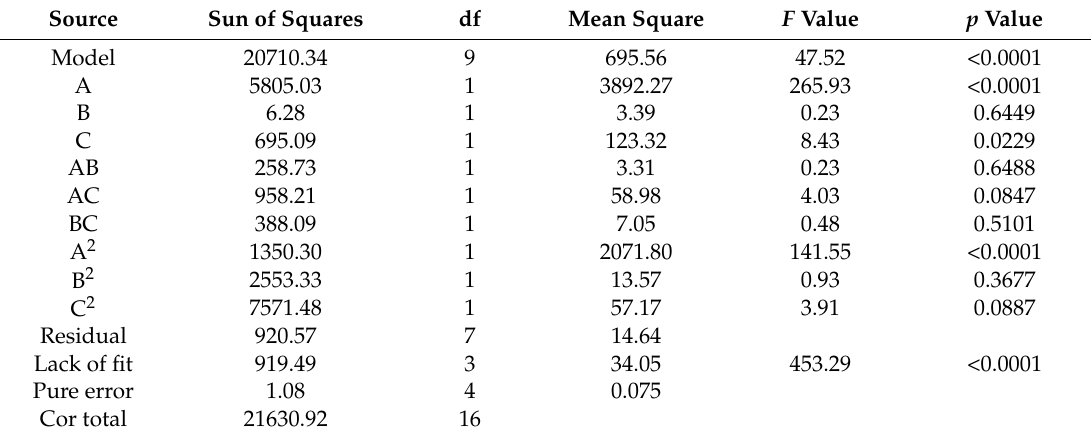
Table 6. ANOVA results of reduced quadratic model for the Pt leaching